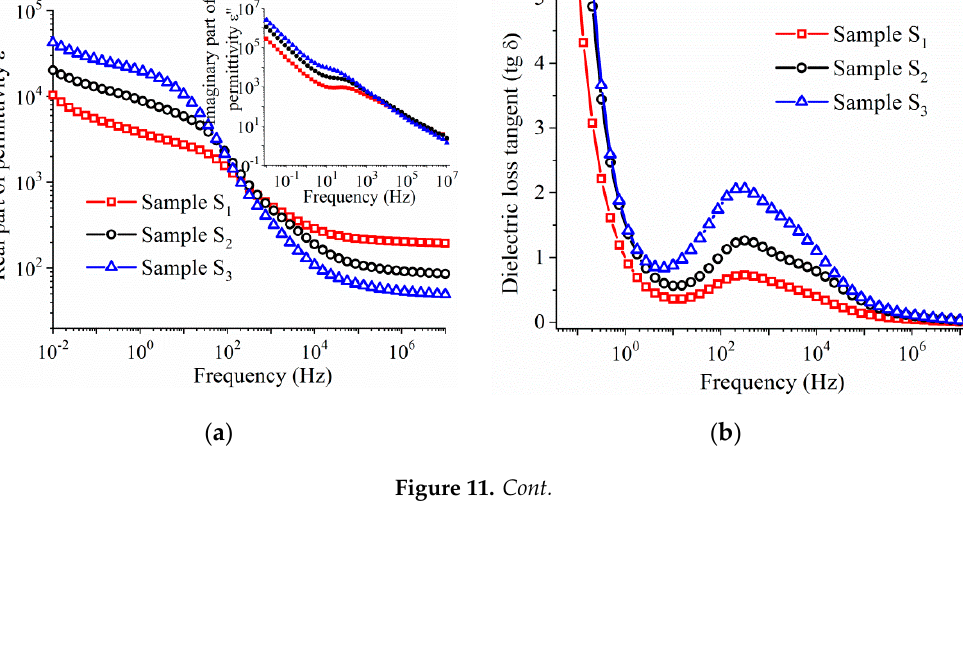
Figure 10. ( a ) Frequency dependence of imaginary part ( M ʺ ) of the dielectric modulus; ( b ) the normalized plots ( M ″ / M ″ max) versus log ( f / f max ).